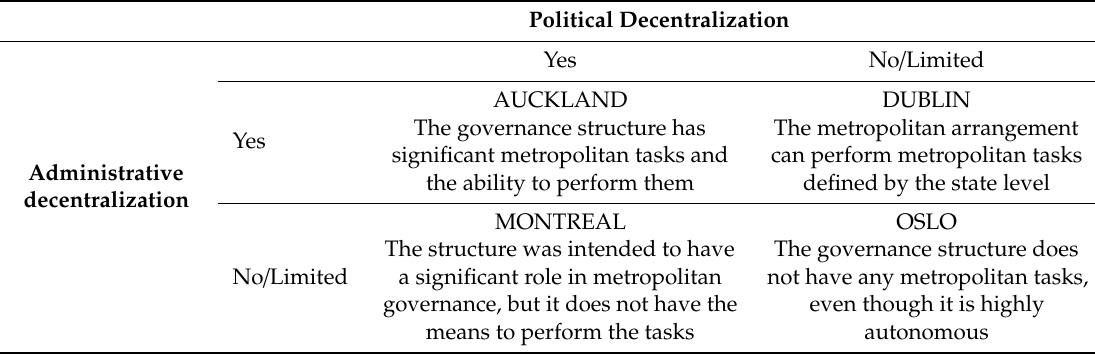
Table 1. Political and administrative decentralization can lead to di ff erent combinations of: (1) having metropolitan tasks; and (2) being able to perform